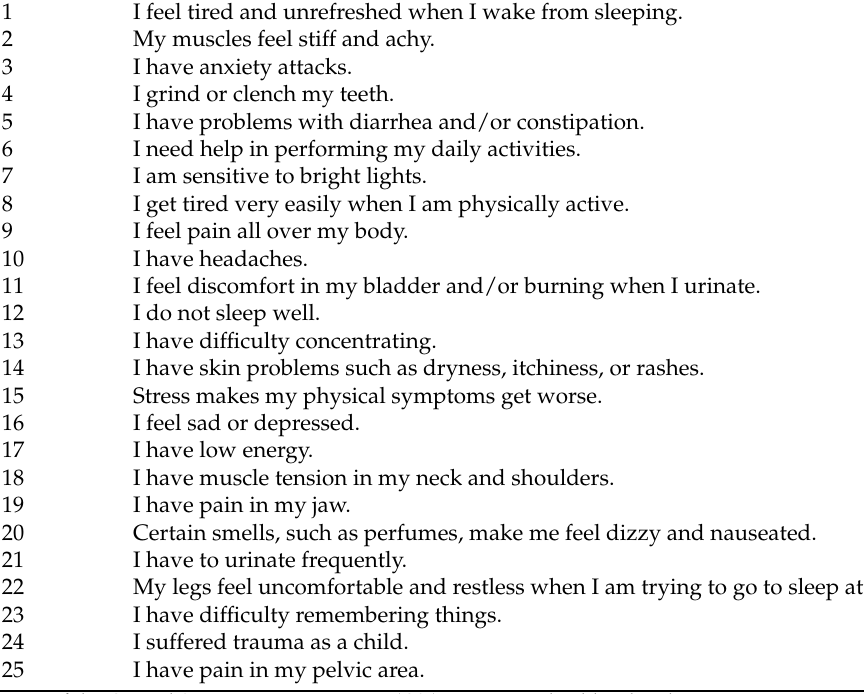
Table 1. Central sensitization inventory: part